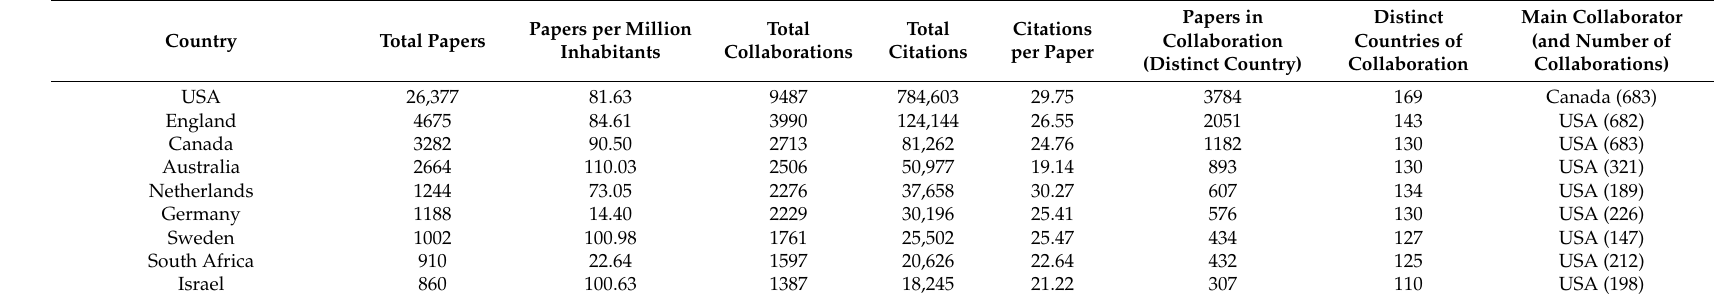
Table 4. Most prolific countries and the